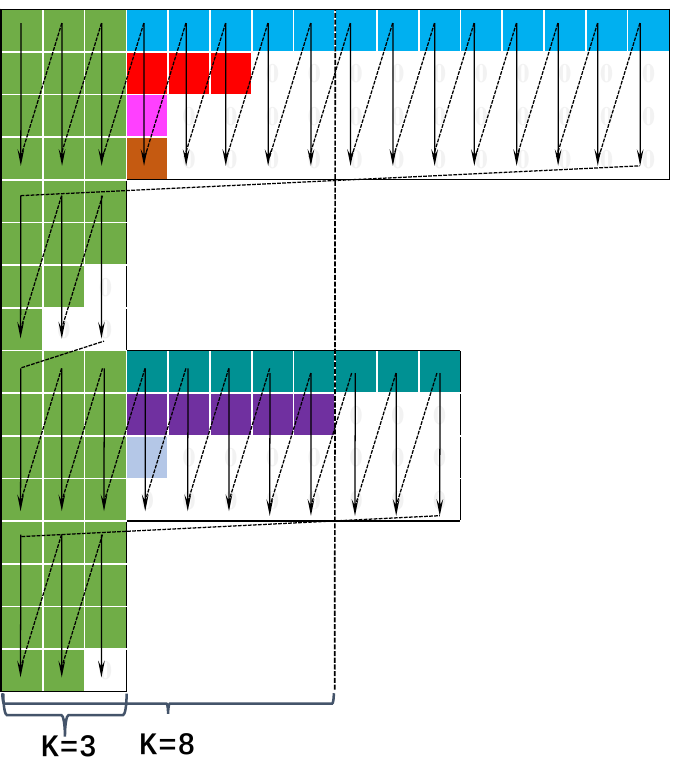
Figure 5. Represent the same matrix A with the SELL-4-8